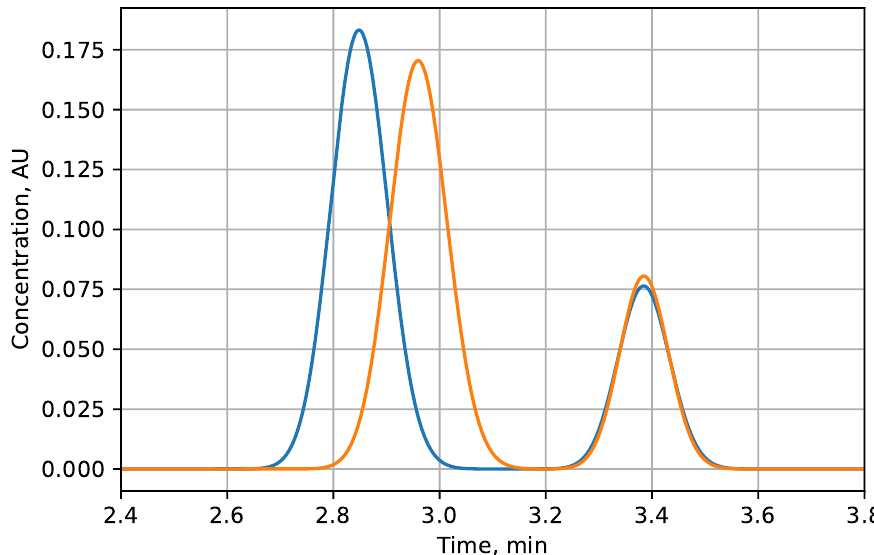
Figure 5. Calculated chromatograms of mono2 and di2 ions in case of gradient (blue) and uniform (orange) columns (AU—arbitrary unit).